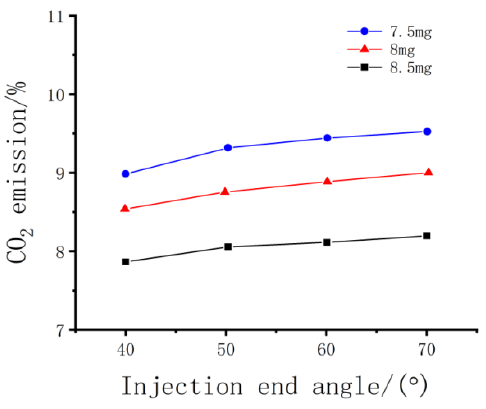
Figure 42. Effect of the injection parameters on CO 2 emissions.